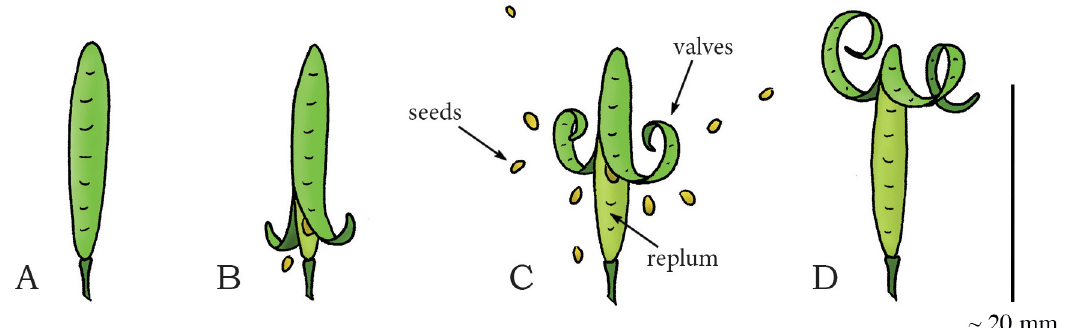
Fig 14. Drying coiling catapult mechanism in Cardamine parviflora (Brassicales). (A) Immature untriggered seedpod. (B) Early stage of dehiscence of the seedpod with two valves starting to coil outwards. (C) When a critical pressure is reached, the valves coil rapidly outwards, discharging the seeds. (D) The seedpod after discharge. Drawings based on schematic drawings in [75]. Scale bar 20